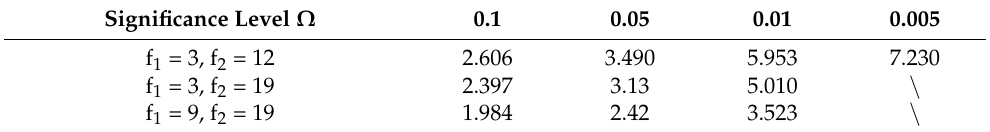
Table 6. Critical values of F Ω (f 1 ,f 2 ) for F verification [26].